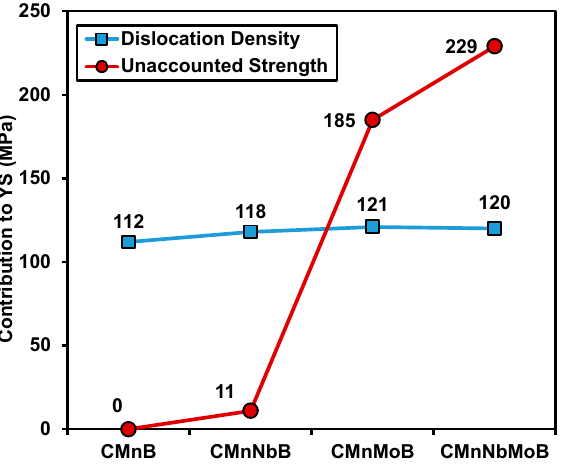
Figure 10. Dislocation density and unaccounted strength values corresponding to all steel grades.